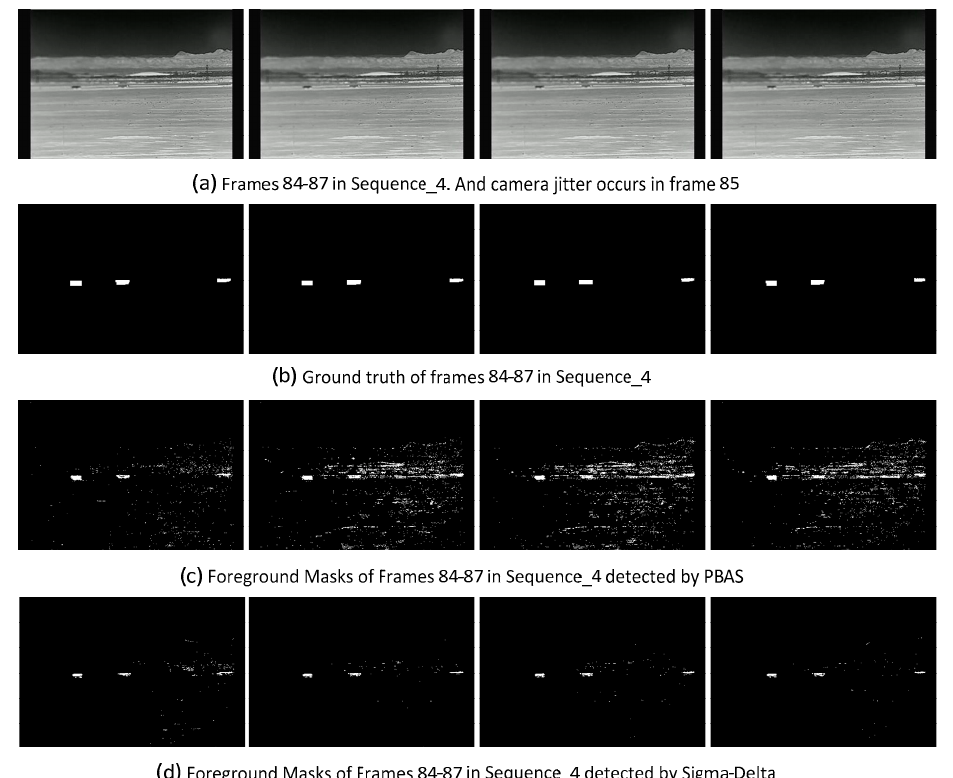
Figure 11. Comparsion of the results detected by different BS algorithms for the challenge of camera jitter.